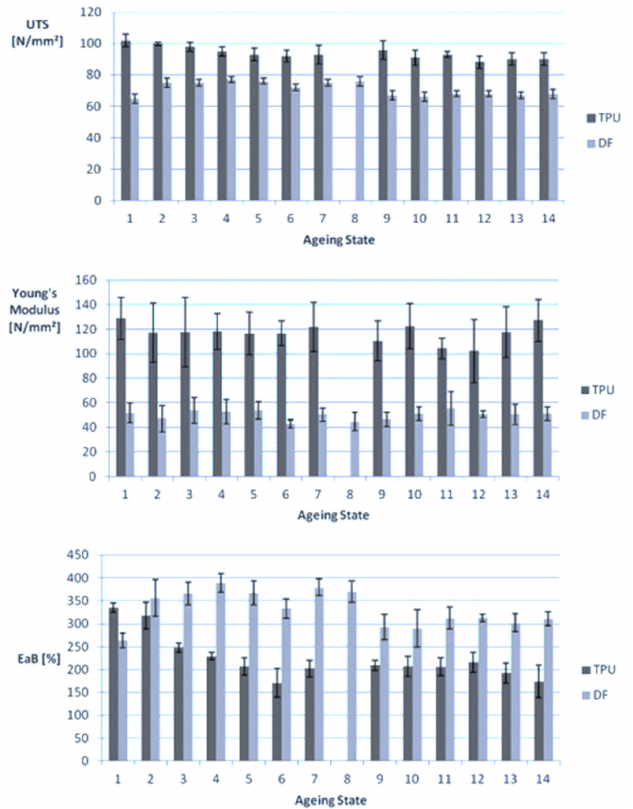
Figure 4. Changes in mechanical properties of parts printed using TPU and DF over different aging states.